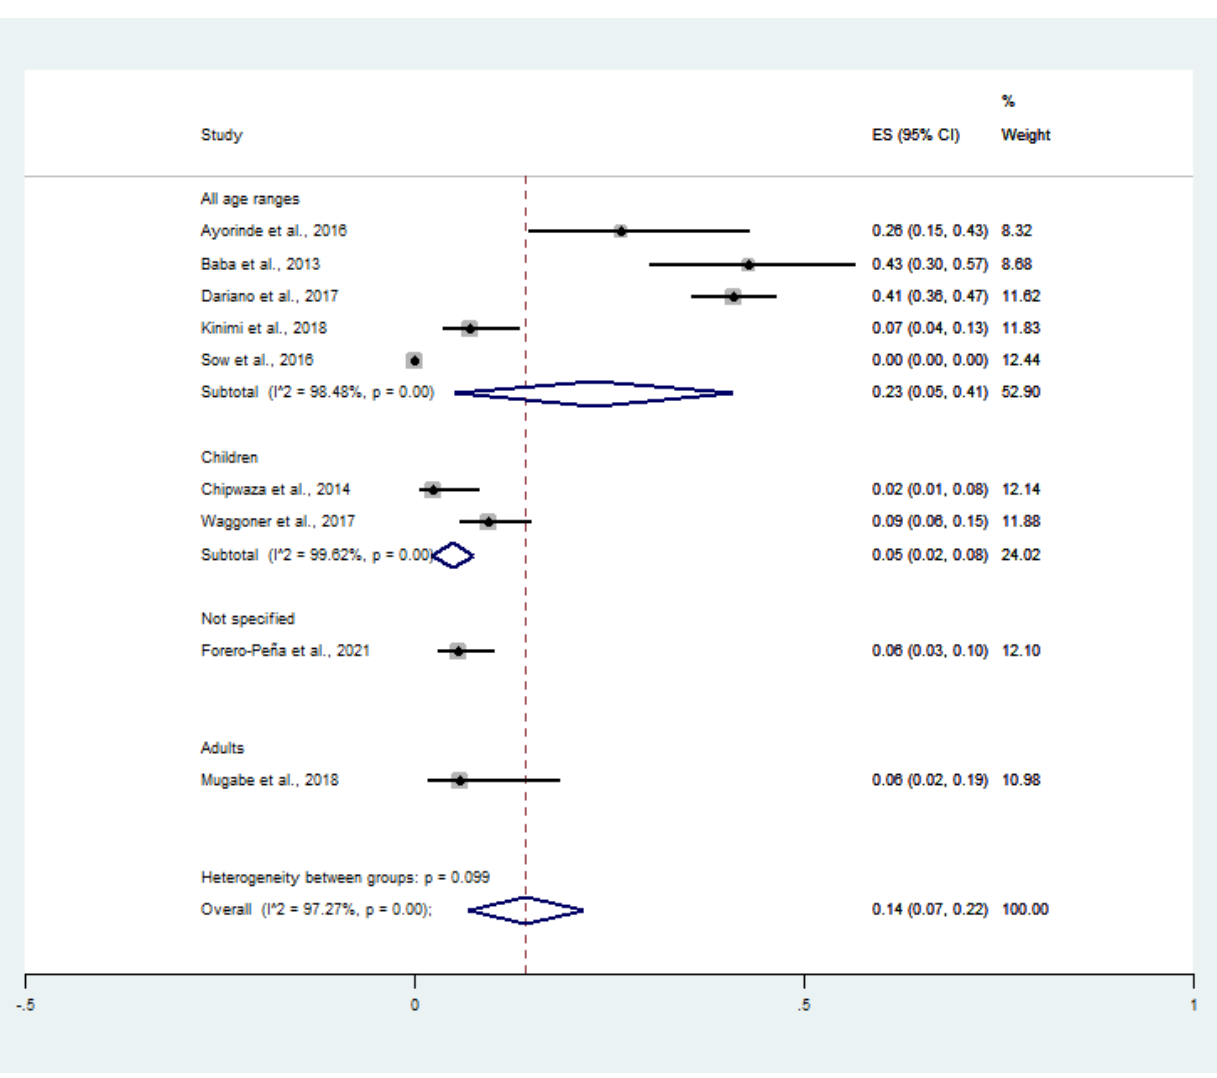
Figure 7. Prevalence of CHIKV infection among malaria patients by age groups: % weighted, the impact proportion of each study to the pooled effect; the black dot symbol on the black horizontal line, the point estimate for each study; the black horizontal line, CI; the white diamond symbol, the pooled prevalence; CI, confidence interval; ES, effect size (prevalence).